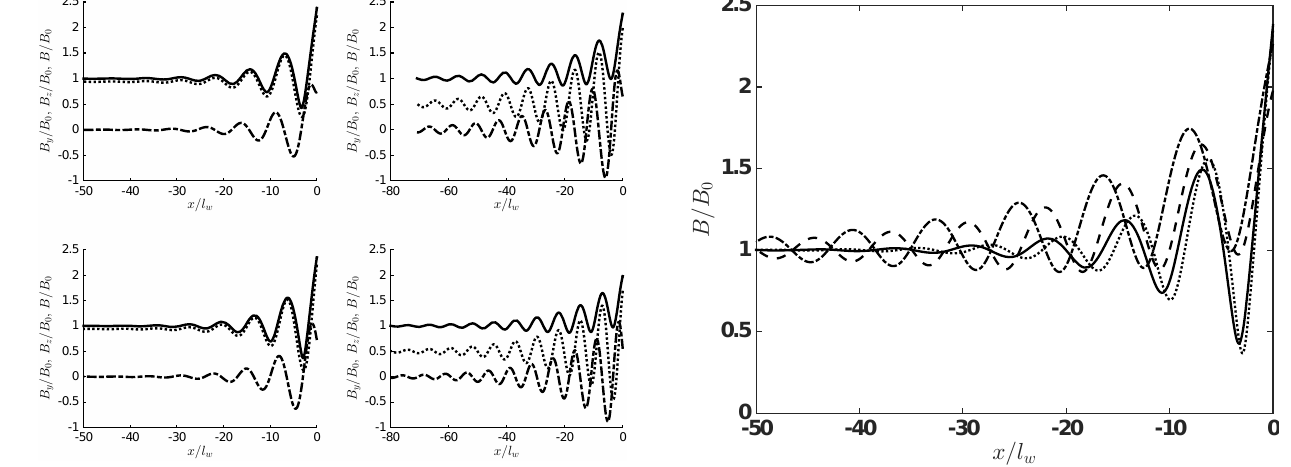
Figure 2. Total magnetic field for the four cases: (1) θ = 70 ◦ , β = 0 . 2 (solid line); (2) θ = 30 ◦ , β = 0 . 2 (dash-dotted line); (3) θ = 70 ◦ , β = 1 . 2 (dotted line); and (4) θ = 30 ◦ , β = 1 . 2 (dashed line).